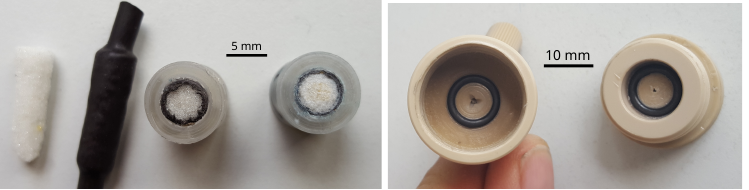
Figure 1. 3D column sample preparation from left to right: sintered glass-bead column, column wrapped in shrink tube, and columns fixed in the plastic mold; both clean and mineralized ( left ) and the sample holder ( right